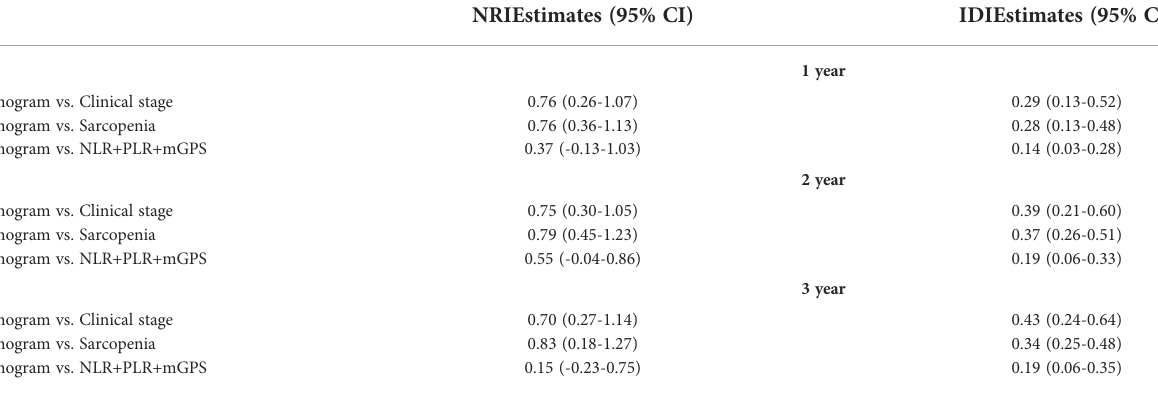
TABLE 4 NRI and IDI used to compare predictive ability of the nomogram with other methods in predicting 1-, 2- and 3-year survival of RCC patients.